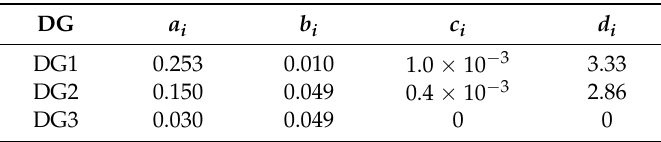
Table 1. Cost coefficients for the considered AC